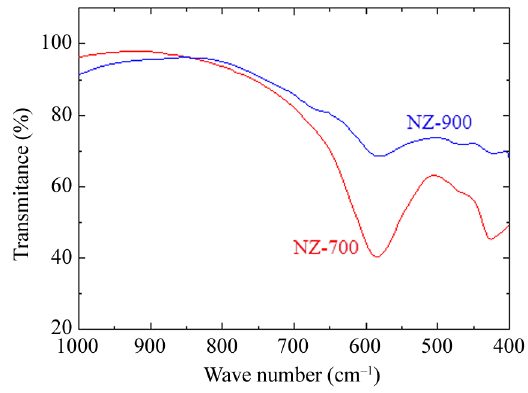
Figure 4. FTIR spectra of specimens NZ-700 and